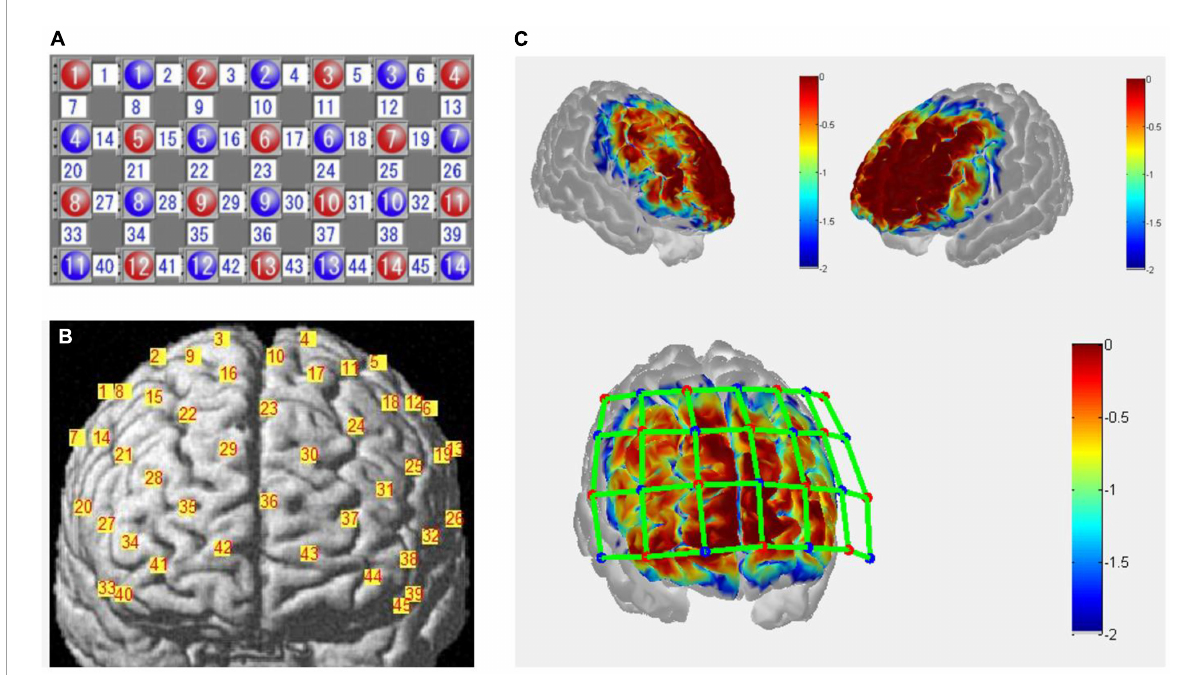
FIGURE2 (A) Optodes arrangement of functional near-infrared spectroscopy (fNIRS) measurements. Numbers in red represent emitters, blue represent detectors, and white represents channels. (B) Channels projected to the rendered brain by a probabilistic registration process using NIRS-SPM (Ye et al., 2009; Tsuzuki and Dan, 2014). (C) Sensitivity map with front and side views over the frontal cortex estimated by Monte-Carlo simulation using the Atlas Viewer from Homer2 (Boas et al., 2002; Aasted et al., 2015). Red dots represent the emitters, blue dots the detectors, and green lines the channels. The colormap represents spatial sensitivity values ranging from –2 to 0 in log10